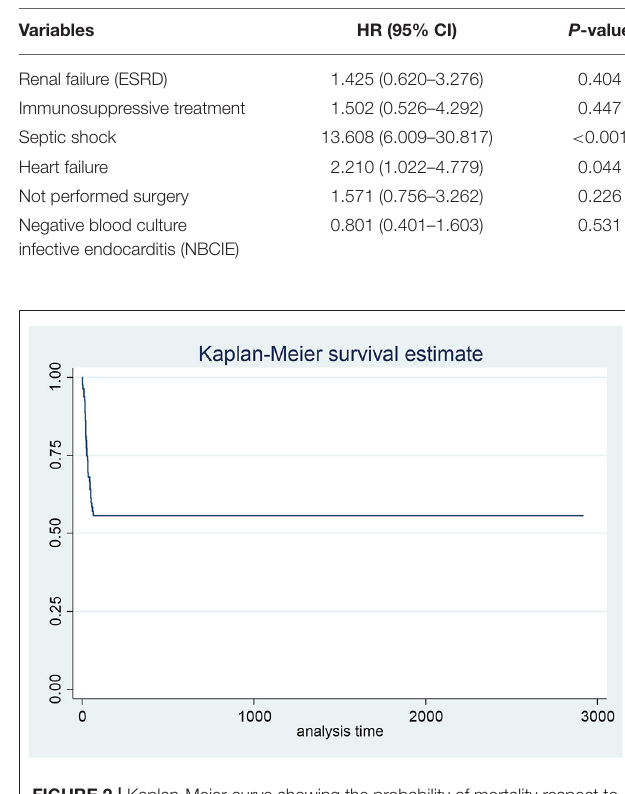
FIGURE 2 | Kaplan-Meier curve showing the probability of mortality respect to the time of